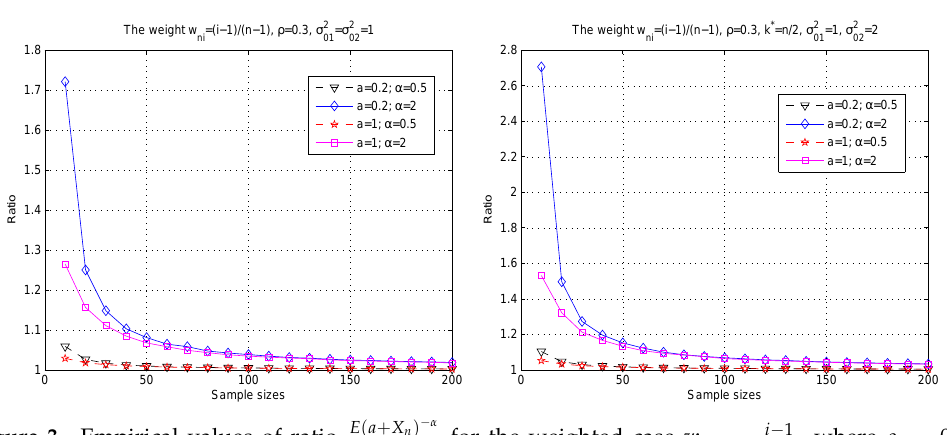
− α for the weighted case w ni = 1, where ρ = 0.3, σ 2 ( a + EX n ) − α = 1, σ 2 = 2. 02 01